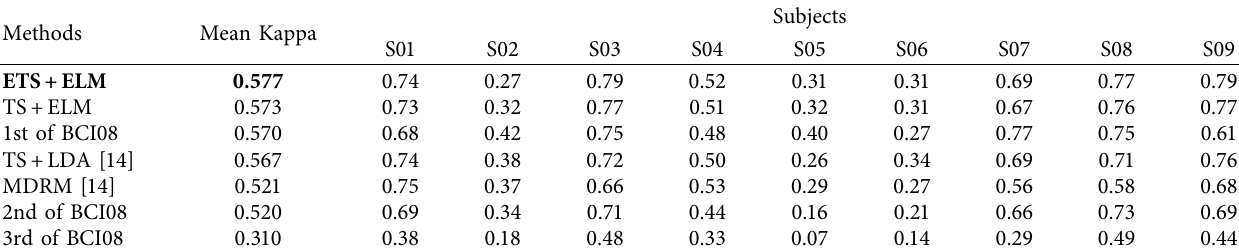
Table 1: Classification results of BCI competition 2008 IIa in kappa